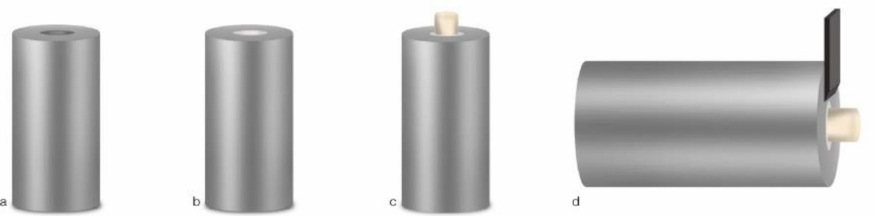
Figure 1. Schematic diagram of the experiment set-up showing how the samples were prepared for SBS strength testing: ( a ) cylindrical metallic blocks; ( b ) the hole in the middle was filled with the CSC; ( c ) after adhesive procedures, a sectioned gelatin capsule was applied on the surface of the CSC and filled with the flowable composite resin; ( d ) a chisel-edge plunger was mounted into the testing machine and positioned, so that the leading edge was aimed at the CSC/adhesive interface. Adapted from Altunsoy, Tanriver, et al. and from Palma et al.